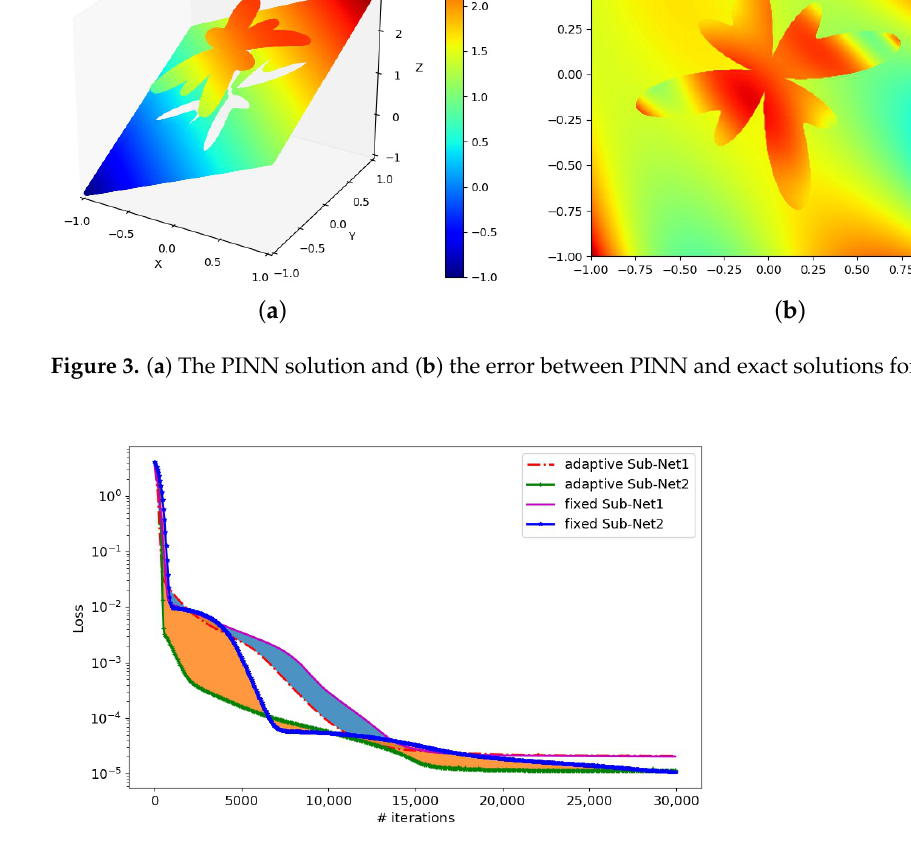
Figure 4. The evolution of loss error for Example